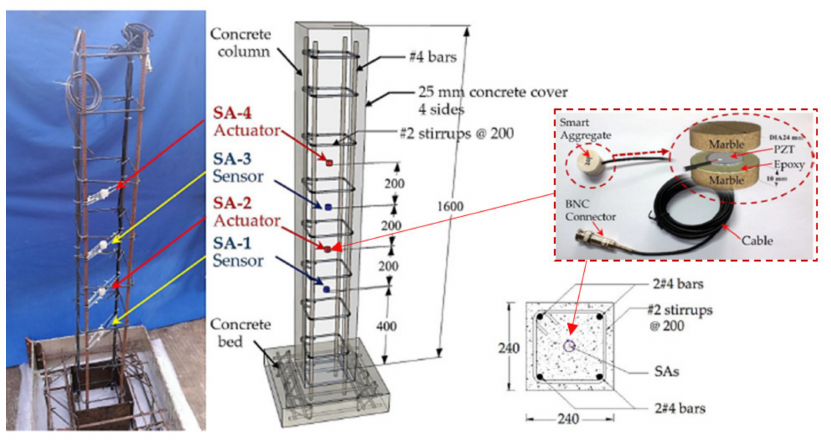
Figure 16. Position and appearance of the SA sensors